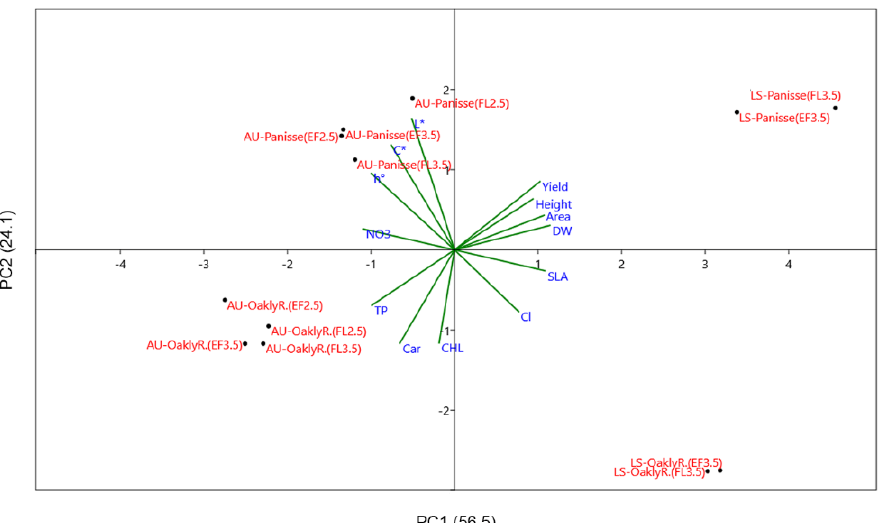
Figure 4. Principal component analysis bi-plot (PC1 vs. PC2) showing the spatial distribution of the main productive and qualitative traits of oak-leaf lettuce as affected by growing season, soilless cultivation system, and genotype. The considered productive traits were yield (Yield), leaf area (Area), and height (H), dry weight (DW), specific leaf area (SLA). The considered qualitative traits were color indices (L*, h°, C*), concentration of total phenols (TP), carotenoids (CAR), chlorophylls, nitrate, and chloride.